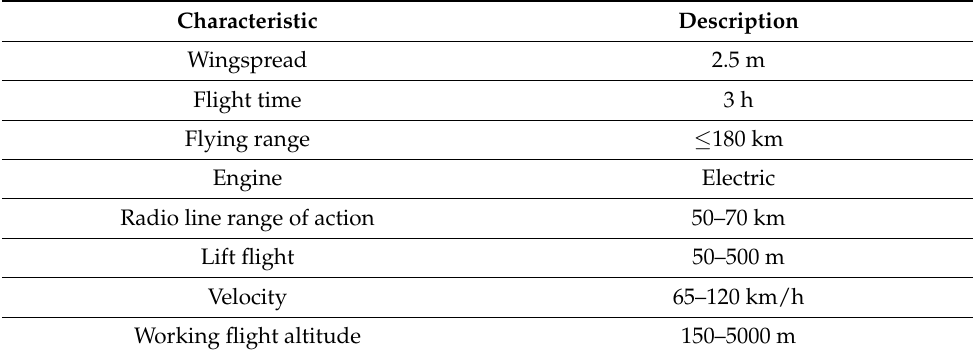
Table 1. Specifications of UAV Supercam